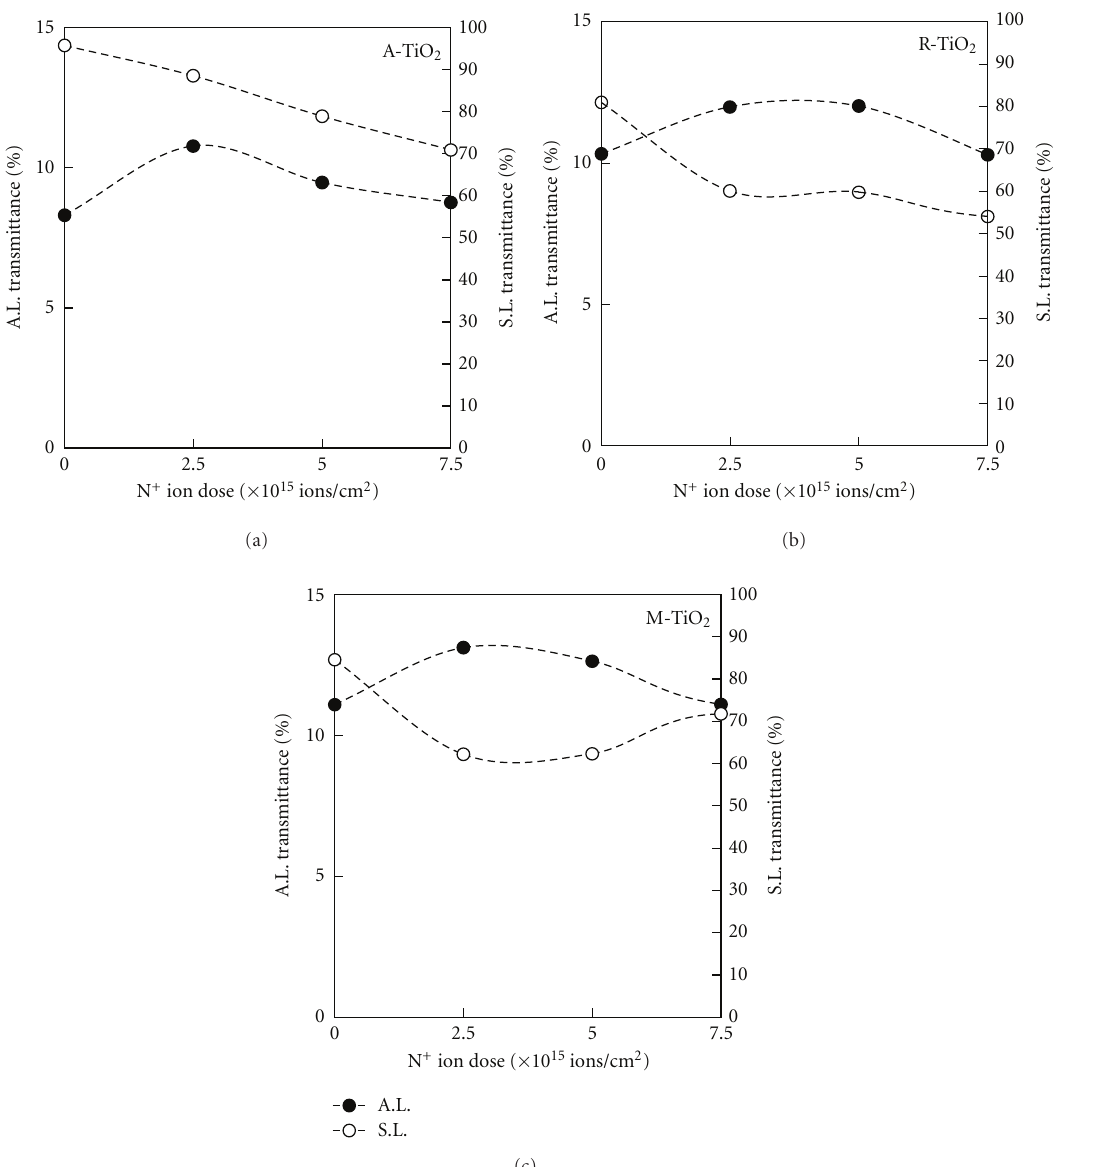
Figure 5: Transmittance changes of the methylene blue solution under sterilization lamp (S.L.) as UV light and artificial lamp (A.L.) as visible light for the unirradiated A-, R-, and M-TiO 2 thin film and the irradiated A-, R-, and M-TiO 2 thin film with an N + ion dose of 2.5 × 10 15 , 5.0 × 10 15 , and 7.5 × 10 15 ions/cm 2 .